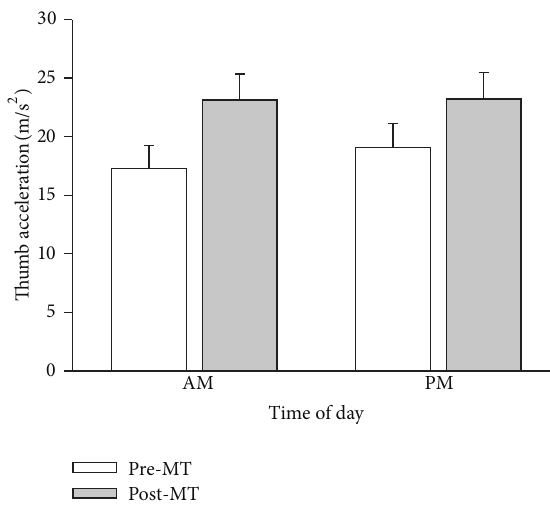
Figure 1: Improvement in maximum thumb acceleration after motor training is not influenced by time of day. Average ( 𝑛 = 10 ) maximum left APB abduction acceleration readings (mean ± SEM) recorded from 22 participants who participated in two experimental sessions: morning (AM) or evening (PM) on separate occasions. Average maximum thumb acceleration values are shown before (pre-MT) and after (post-MT) motor training. Maximum acceleration increased significantly following motor training, and this effect was independent of time of